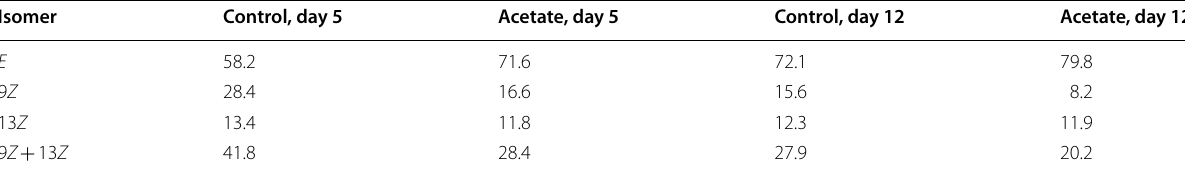
Table 1 Relative content of individual astaxanthin isomers in H. pluvialis cells compared to total astaxanthin, %